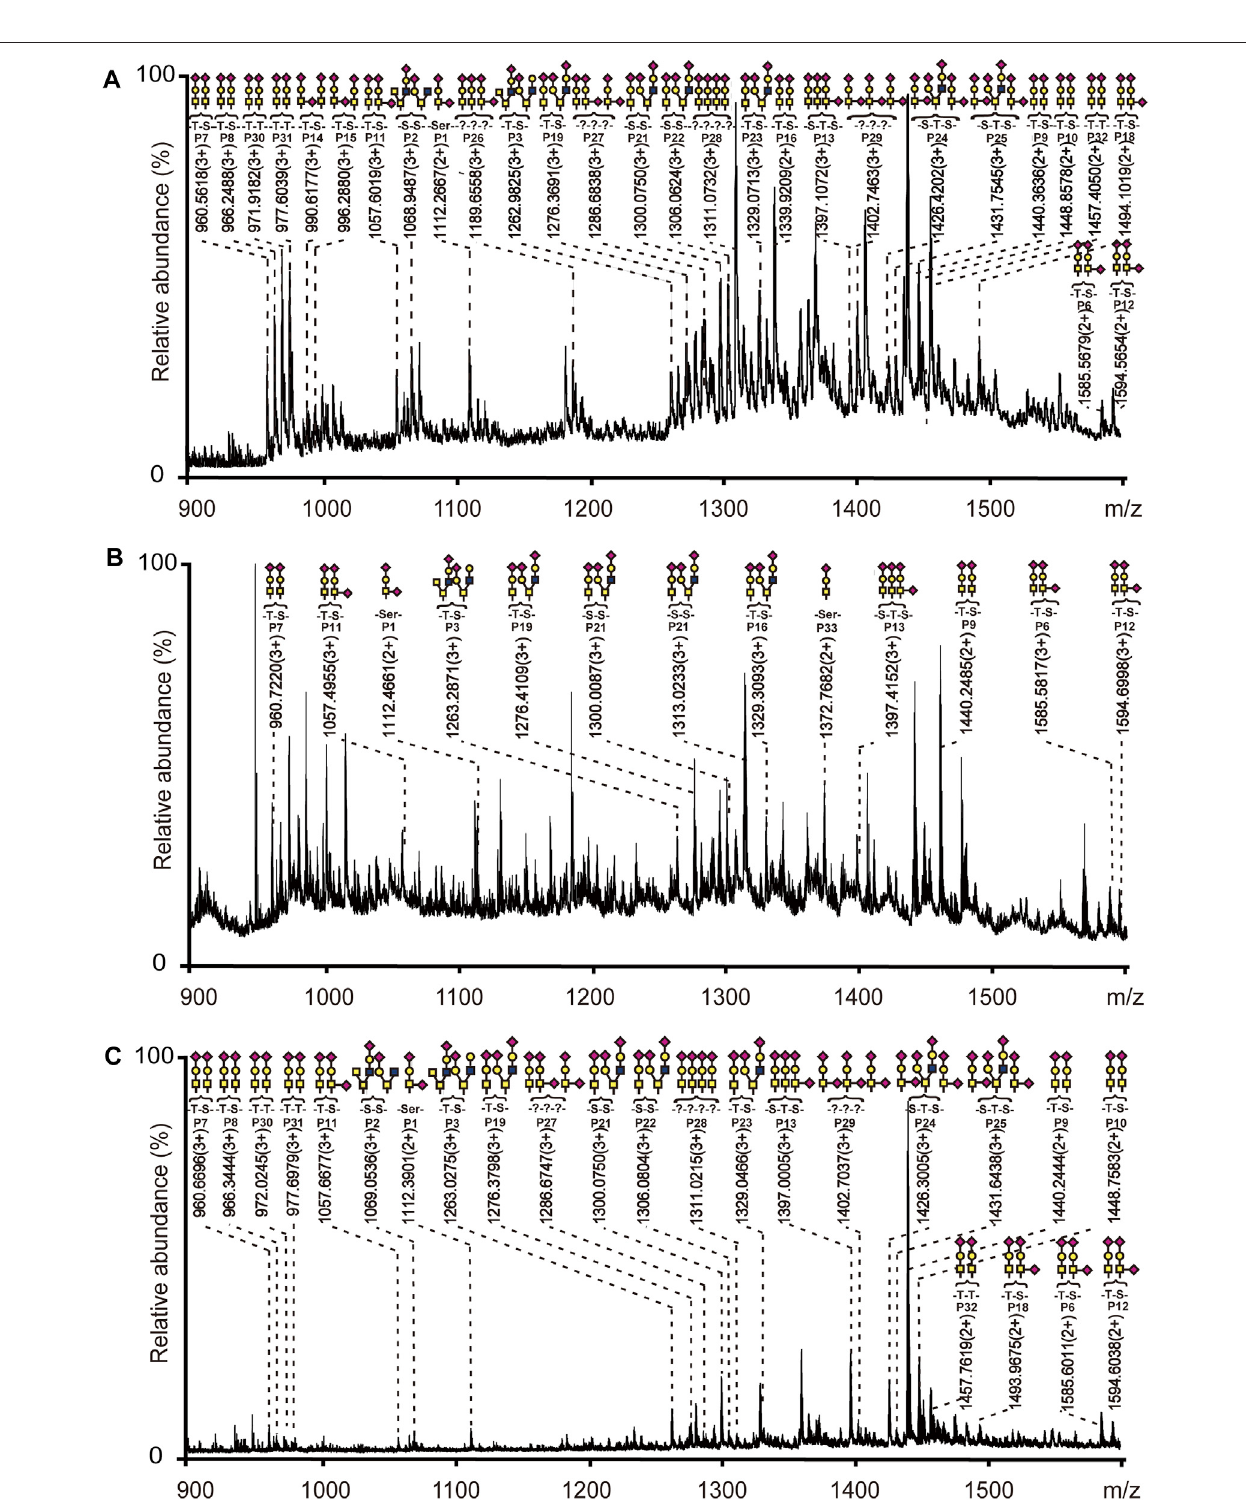
FIGURE3| MassspectraofdigestmixtureafterenrichmentwithHBSorZIC-HILICmaterials. (A) BovinefetuinandBSAatamassratioof1:20enriched withHBS. (B) Bovine fetuin and BSA at a mass ratio of 1:20 enriched with ZIC-HILIC. (C) Bovine fetuin and BSA at a mass ratio of 1:200 enriched with HBS. Glycopeptides are marked with their glycan structures: , GalNAc; , GlcNAc; , galactose; and , N-acetylneuraminic acid (Neu5Ac). The detailed information about the peptide sequences and glycosylation is shown in Supplementary Table S1 .